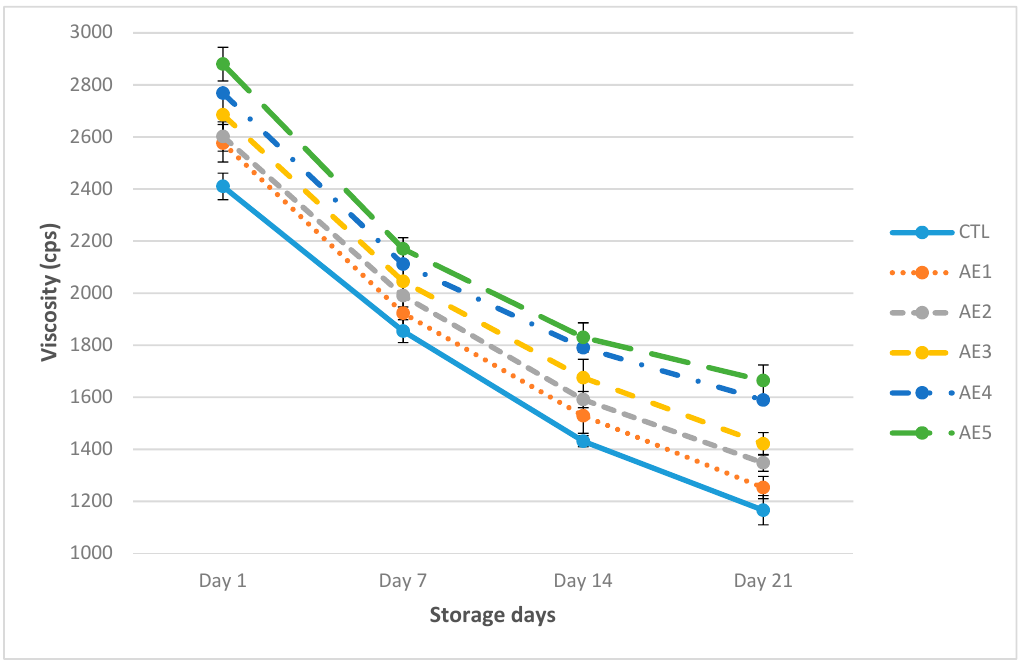
Figure 3. Viscosity of probiotic yoghurt with addition of APPE. CTL: Without APPE; AE 1 : 1% APPE; AE 2 : 2% APPE; AE 3 : 3% APPE; AE 4 : 4% APPE; AE 5 : 5% APPE.